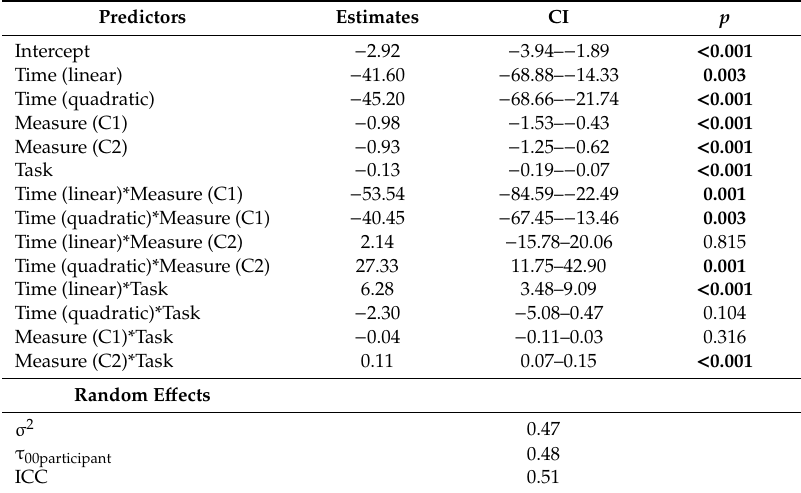
Table 2. Estimates and significance values for fixed-e ff ects in the joint model of subjective